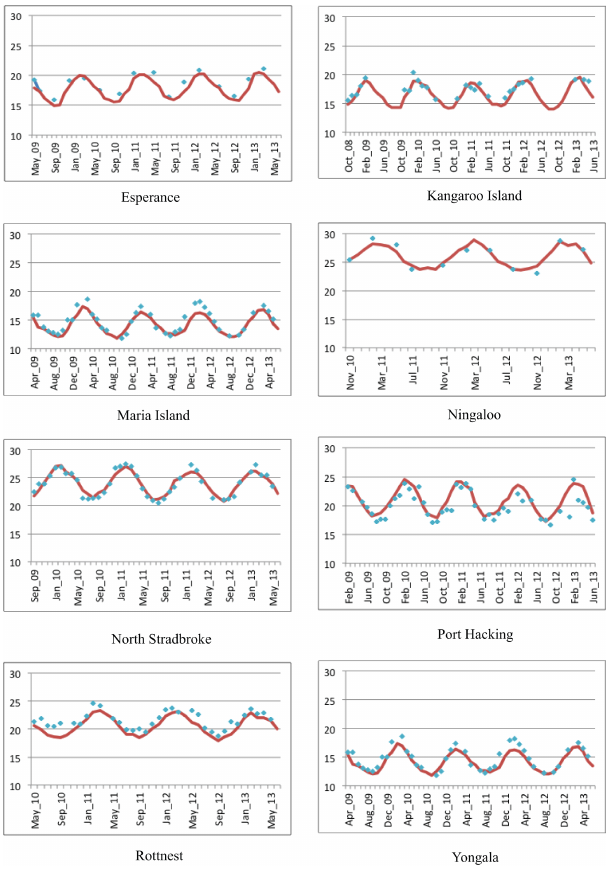
Figure 3. Comparison of sea surface temperature from the ob- servations at the IMOS National Research Stations with HadiSST (Rayner et al.,